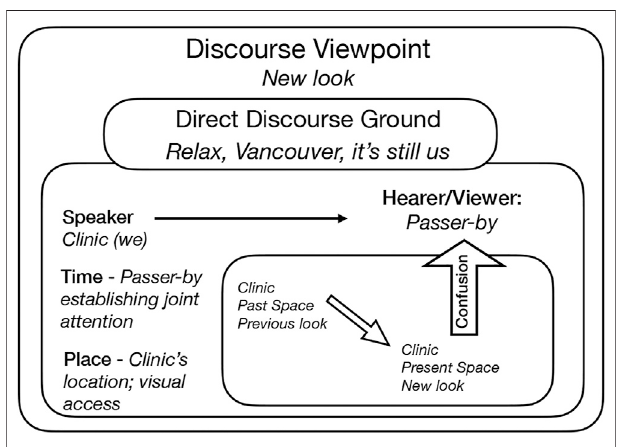
FIGURE 11 | The discourse structure of the Relax, Vancouver